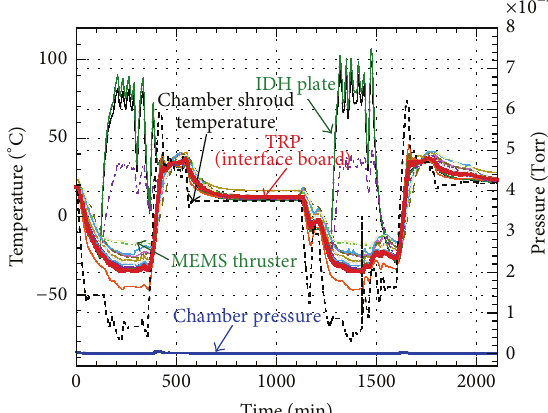
the configuration of front and back sides of the IDH plate made of Al-6061 with a black anodized surface treatment. The test heater was attached on the back side of the IDH to provide the required heat flux by adjusting the input power. The black anodized surface towards the −𝑍 panel side was opened and the remaining areas were covered by the test MLI for efficient radiative heat transfer to the target by minimizing heat loss from both sides of the IDH plate.